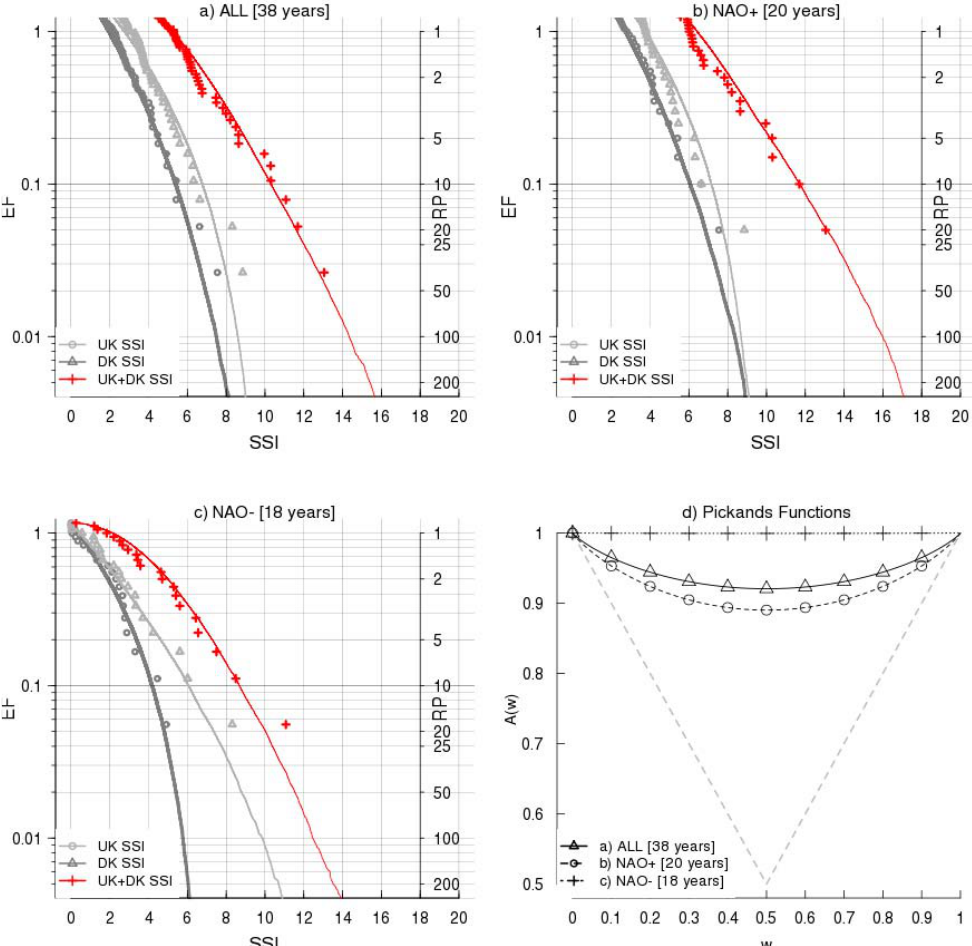
Fig. 8. SSI event Exceedance Frequency (EF) for the regions south-UK, west-DK and south-UK + west-DK. Dots/Triangles/Crosses are observed values, while solid lines are estimates based on GPD (south-UK,west-DK) or EV Copula (south-UK + west-DK). Panel (d) depicts the Pickands function for south-UK – west-DK copulas for the three cases considered; no extremal dependence is evident during the negative NAO phase (NAO − ), while a weak dependence structure emerges during the positive NAO phase (NAO+).